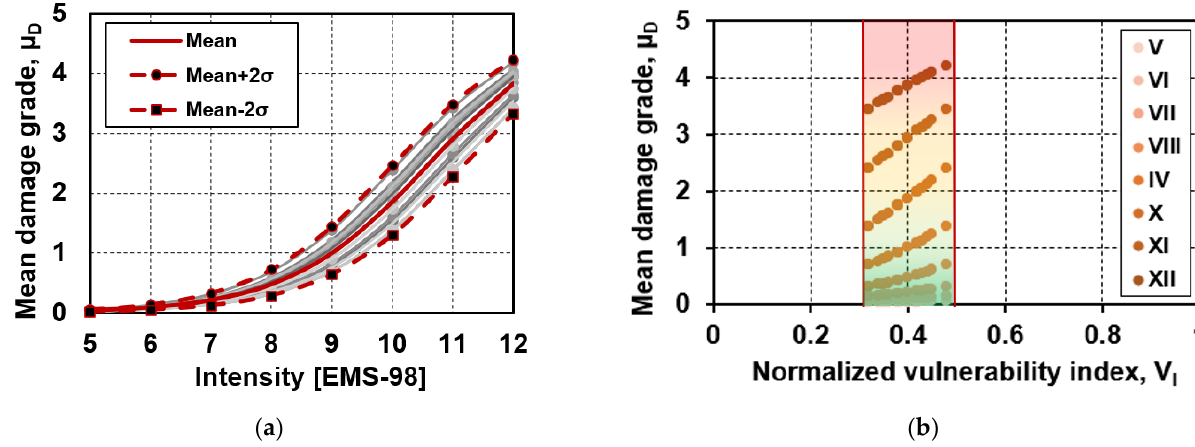
Figure 5. Vulnerability curves for the case study aggregate ( a ) and statistical variation of the vulnerability index for each macroseismic intensity ( b ).